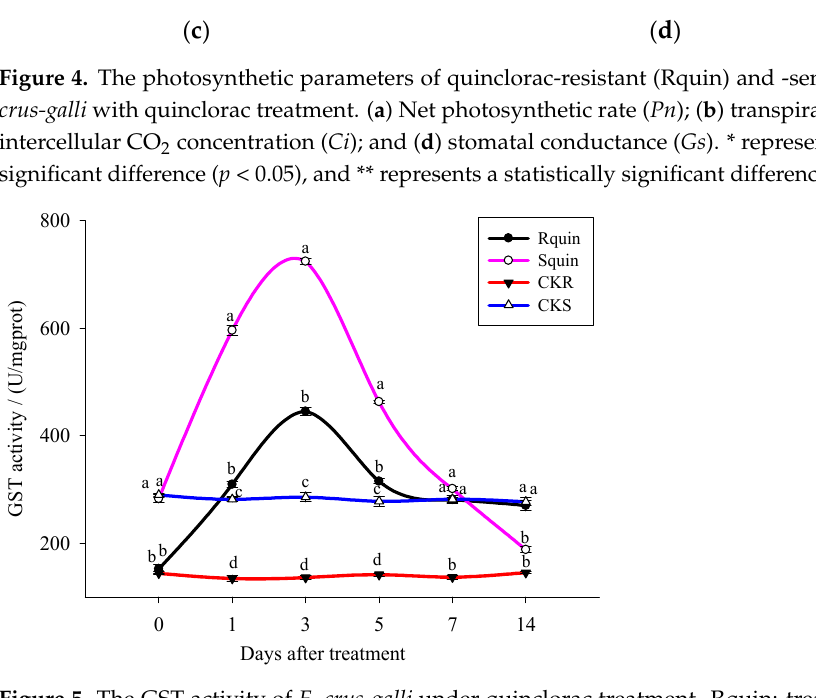
Figure 5. The GST activity of E. crus-galli under quinclorac treatment. Rquin: treating quinclorac- resistant E. crusgalli with quinclorac; Squin: treating quinclorac-sensitive E. crusgalli with quinclorac; CKR: treating quinclorac-resistant E. crusgalli with water; CKS: treating quinclorac-sensitive E. crusgalli with water. Lower case letters on histogram is expressed as least square means ± standard error (P<0.05). Data are least square means ± standard error.